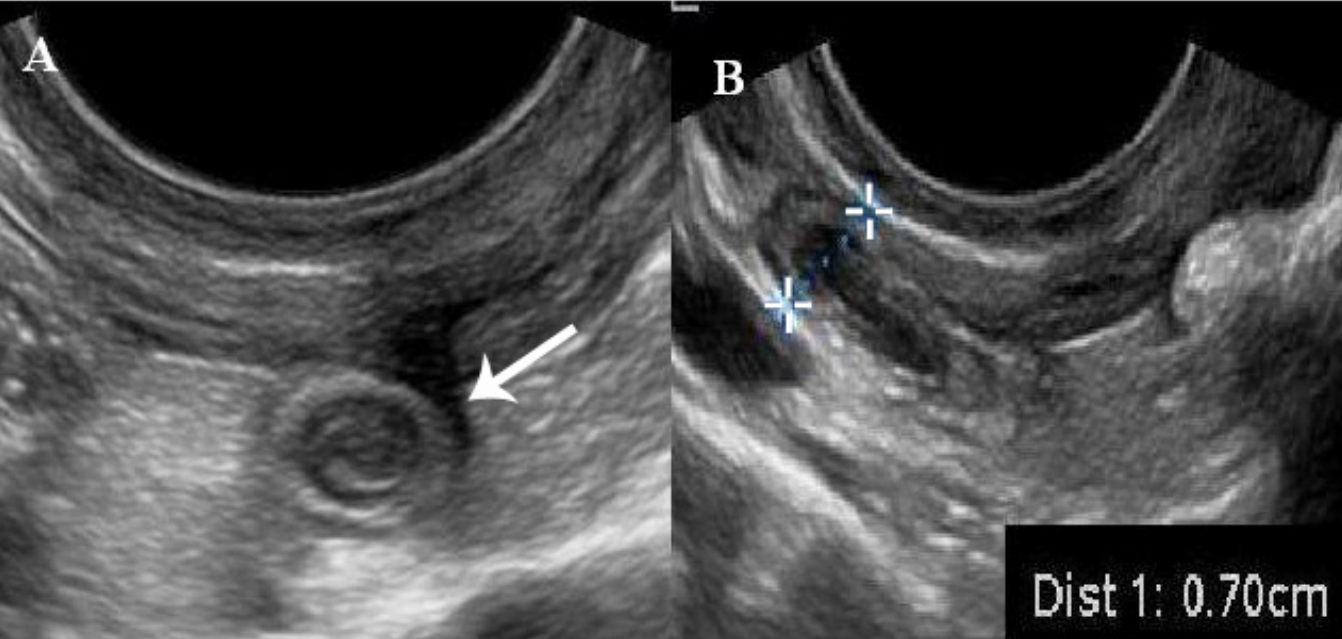
Figure 1. Transvaginal imaging of the right adnexa. (A) Transverse view of the appendix. (B) Long view of the appendix measuring 0.7